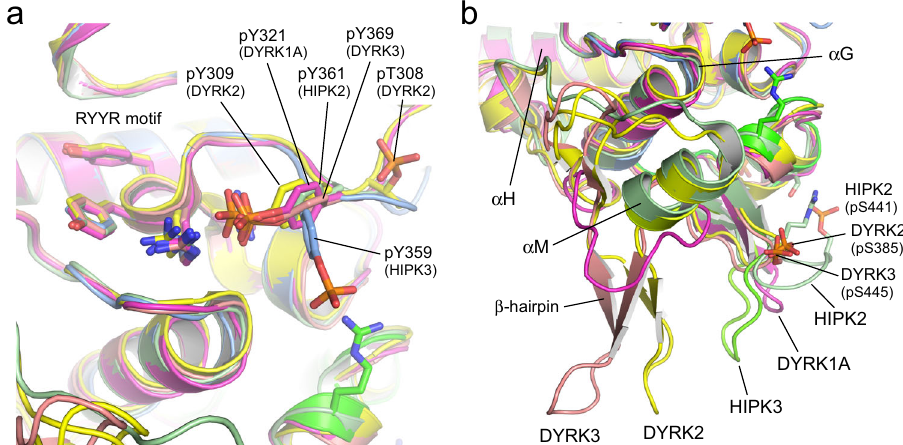
Fig. 3 Coordination of the phosphorylated tyrosine and the CMGC insert region in HIPKs and DYRKs. a In HIPK2, DYRK1A, DYRK2, and DYRK3 the phosphorylated tyrosine residue of the activation loop forms salt bridges with the arginines of the R(Y/F)YR motif. In HIPK3 instead, pY359 interacts with R431 of the CMGC insert region. b Variations of the β -hairpin loop conformation in the CMGC insert region. Protein structures shown in this fi gure are HIPK2 (6P5S, palegreen), HIPK3 (7O7I, blue/green), DYRK1A (2VX3, magenta), DYRK2 (3K2L, yellow), and DYRK3 (5Y86,